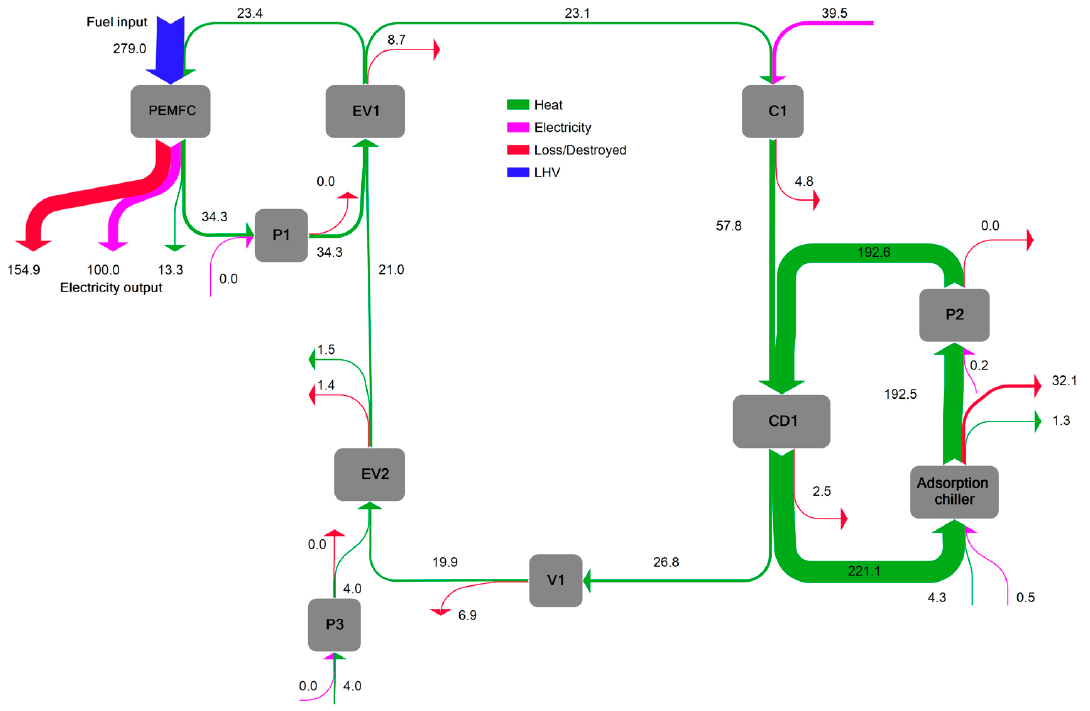
Figure 5. Sankey diagram of exergy flow within the case A system.